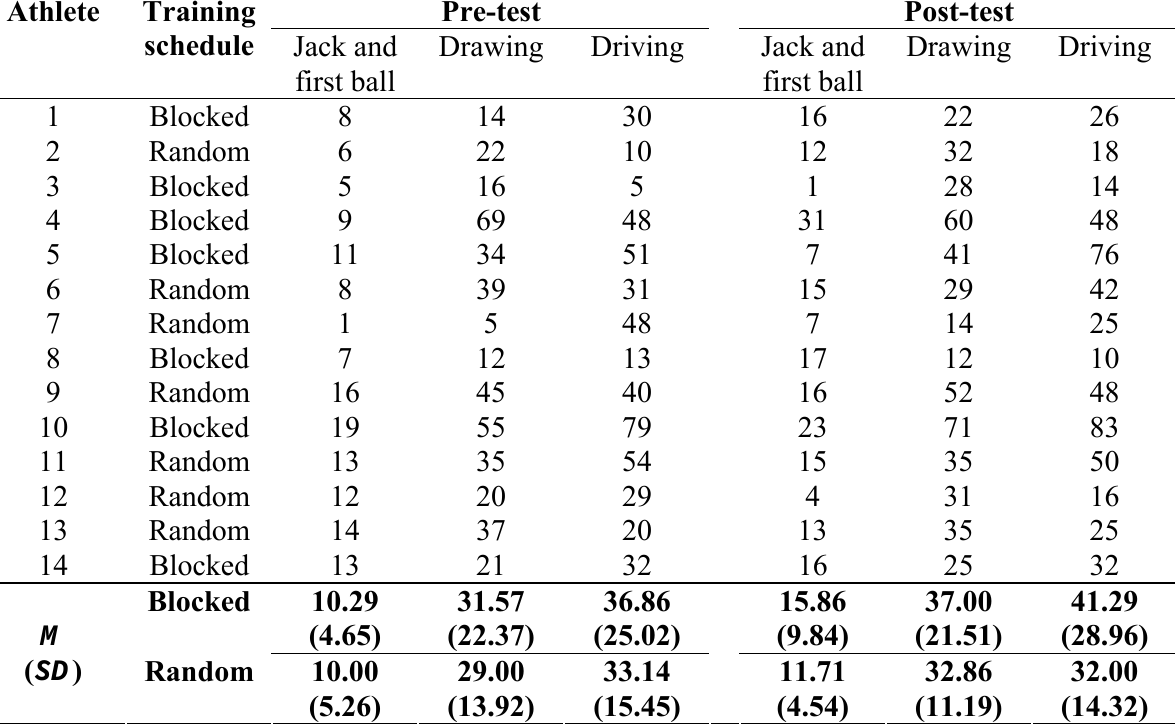
Athlete Intervention Schedule and Boccia Skills Results from Pre- and Post-Tests